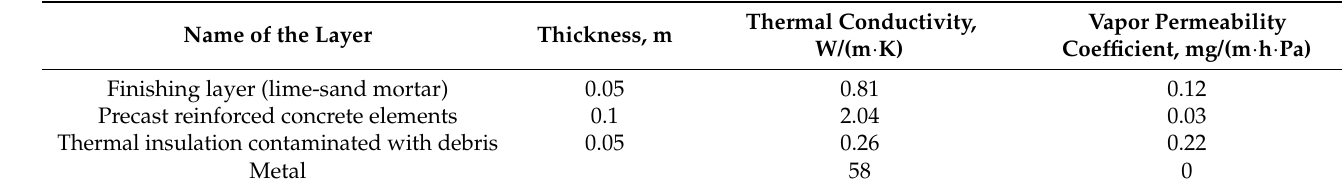
Table 1. Characteristics of the layers of the buildings enclosing structures.